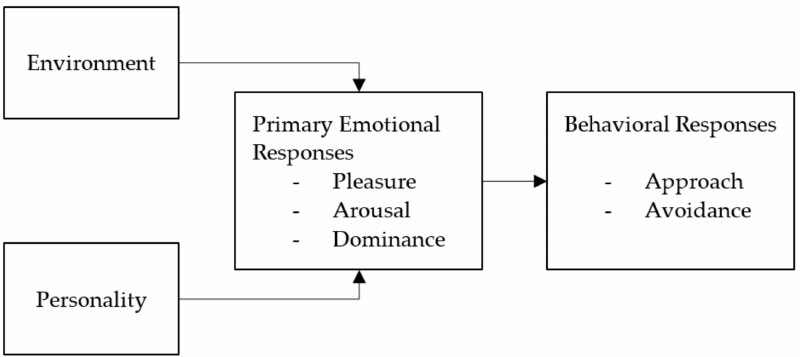
Figure 1. Classic environment model ([29], page 8). Reprinted from An Approach to Environmental Psychology by Albert Mehrabian and James A. Russell, reprinted courtesy of The MIT